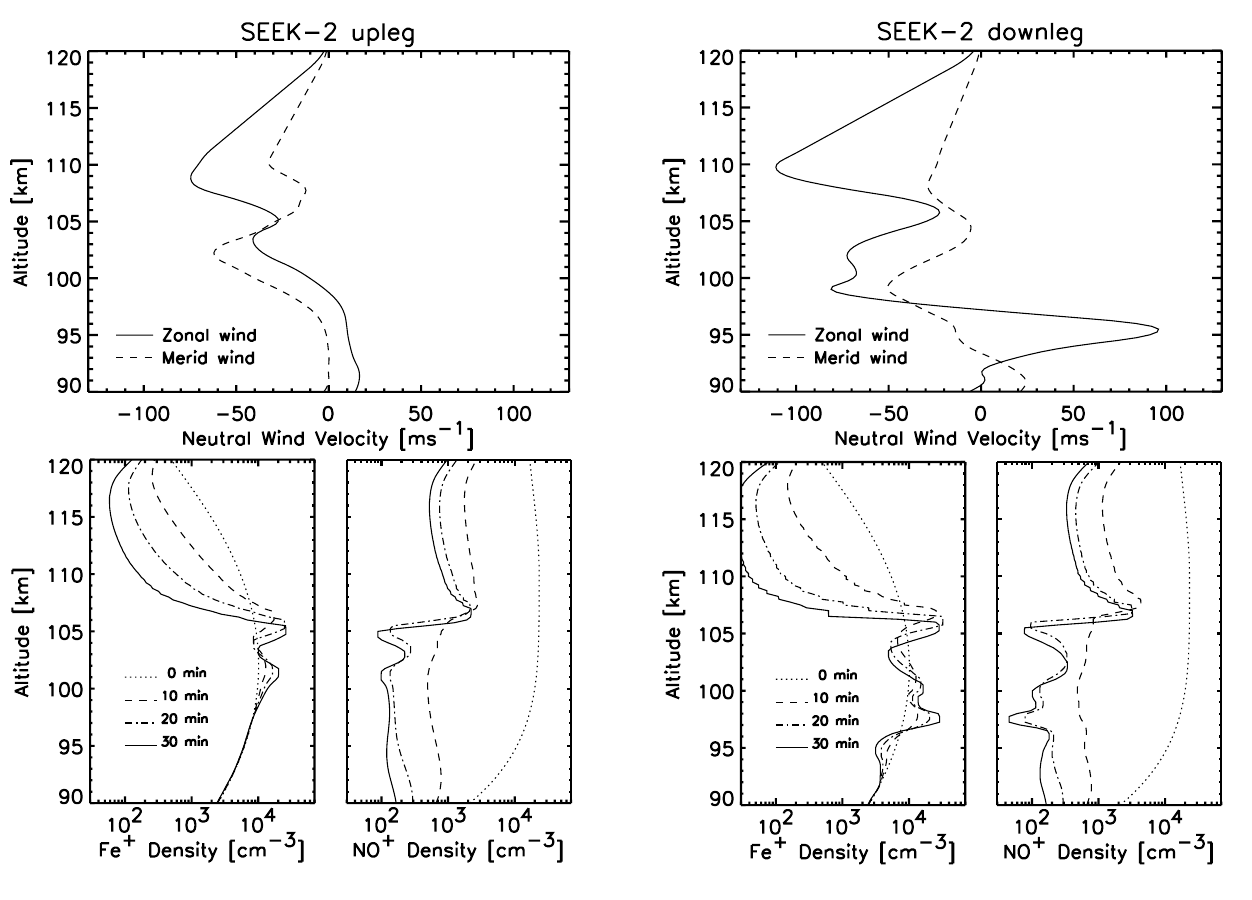
Fig. 3. Same as Fig. 2 but for the downleg of